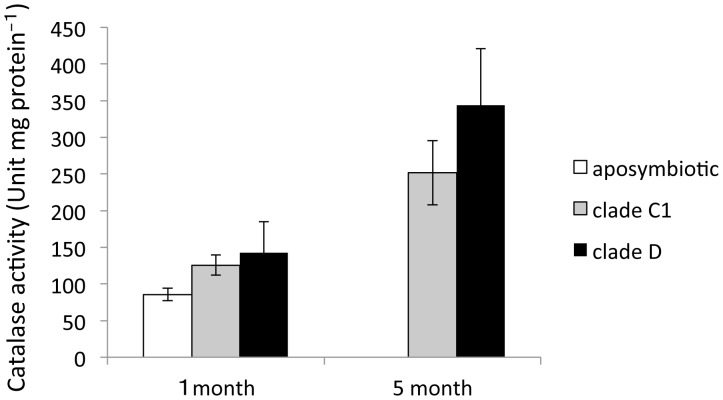
Catalase activity of aposymbiotic and symbiotic polyps associated with clade C1 or D algae, 1 and 5 months after inoculation.Each value represents the mean ± S.E. (n = 3). There is no significant differences between the treatments (Tukey–Kramer honestly significant difference (HSD) tests: P>0.05).